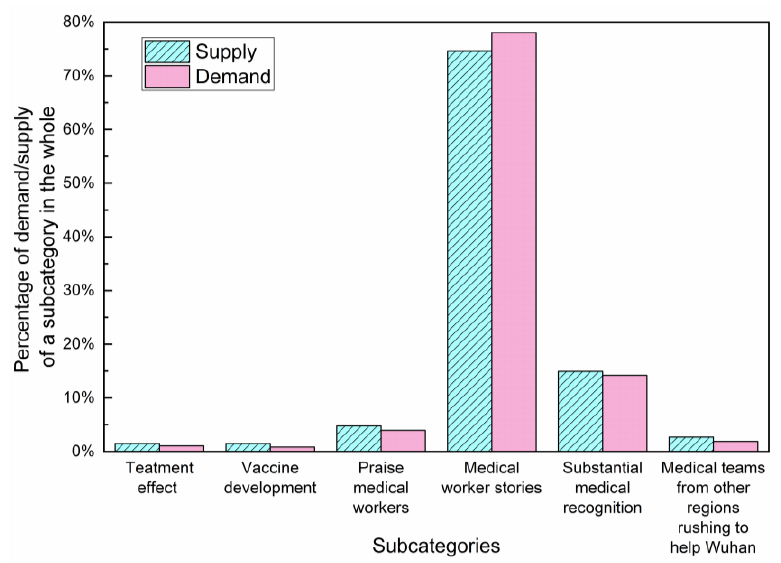
Figure 14. The degree of information matching between supply and demand in the stable stage.